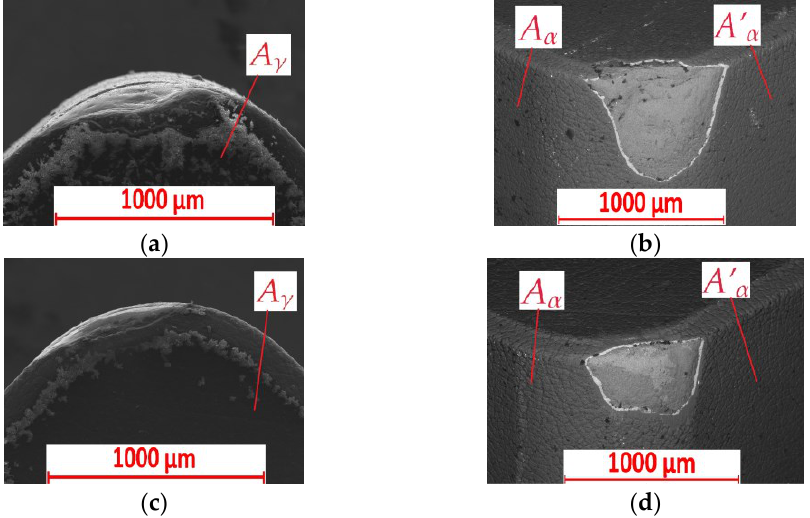
Figure 10. Results of SEM measurements of cutting inserts after turning of: ( a , b ) FEPA 046 samples; ( c , d ) FEPA 100 samples: A γ — rake surface, A α — principal flank surface, A ’ α — auxiliary flank surface.